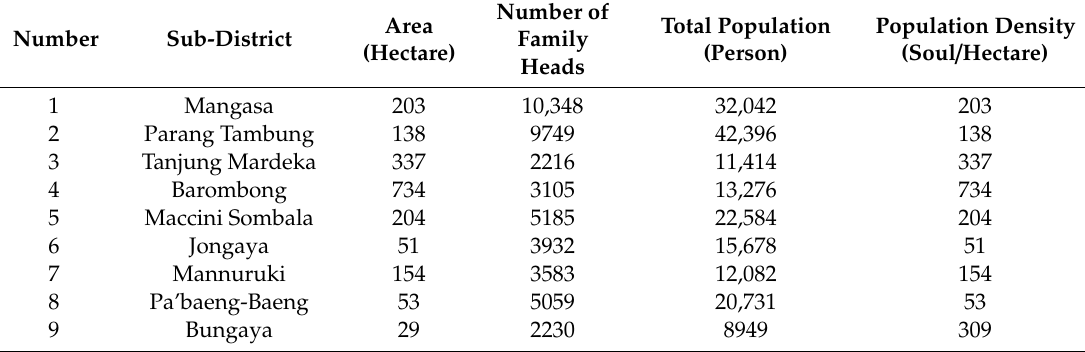
Figure 2. The new city area of Metro Tanjung Bunga, Makassar City as the study area. Source: The author and Google Maps @ . Table 1. The population of the new city area of Metro Tanjung Bunga, Makassar